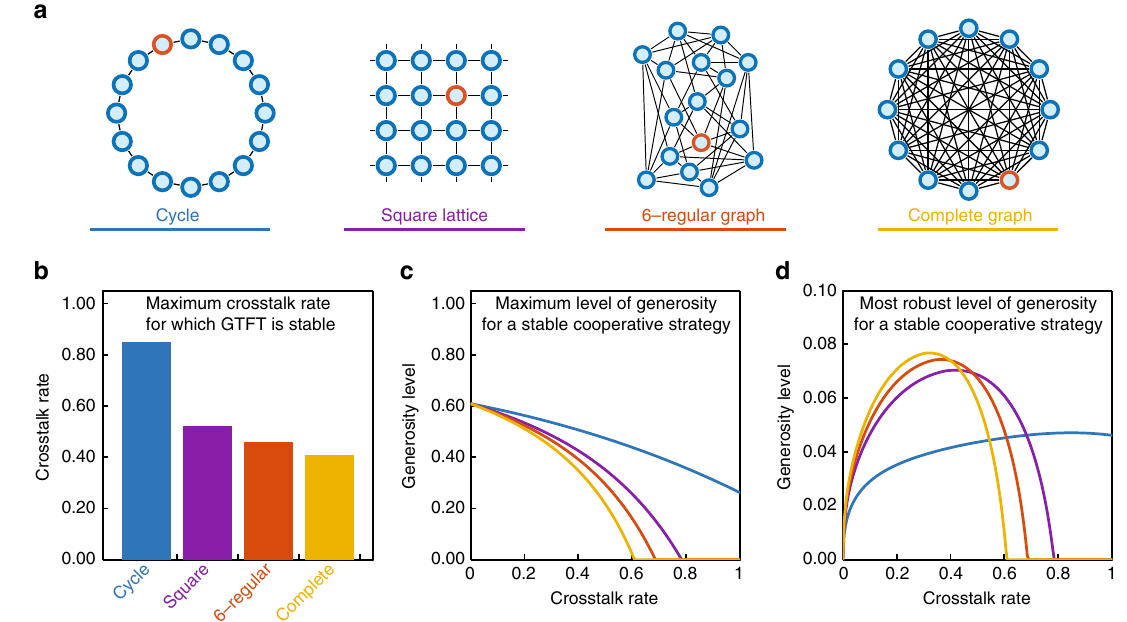
Fig. 3 Population structure and crosstalk rate substantially affect stationary payoffs and evolutionary stability. a Examples of the investigated population structures: cycle, square lattice, 6-regular graph, complete graph. Defectors (red nodes) are randomly placed within the population. b Maximally tolerated crosstalk rate ( γ ) in various population structures such that the payoff of the ALLD player remains below the payoff of the GTFT players (for a generosity parameter q fi xed to 1/3). c Maximum level of generosity ( q M ) such that the average payoff of the GTFT players exceeds the payoff of the ALLD player. The circle allows players to be most generous when crosstalk is common. d Most robust level of generosity ( q R ) maximizing the relative payoff advantage of the GTFT players compared to the ALLD player. When crosstalk is rare, a small increase in the crosstalk rate allows players to be more generous, to decrease the chance that defection spreads across the population. However, when crosstalk becomes common, a further increase of γ requires the players to become less generous to constrain the payoff of the ALLD player. Parameter values: number of players N = 16 (one ALLD player), bene fi t b =